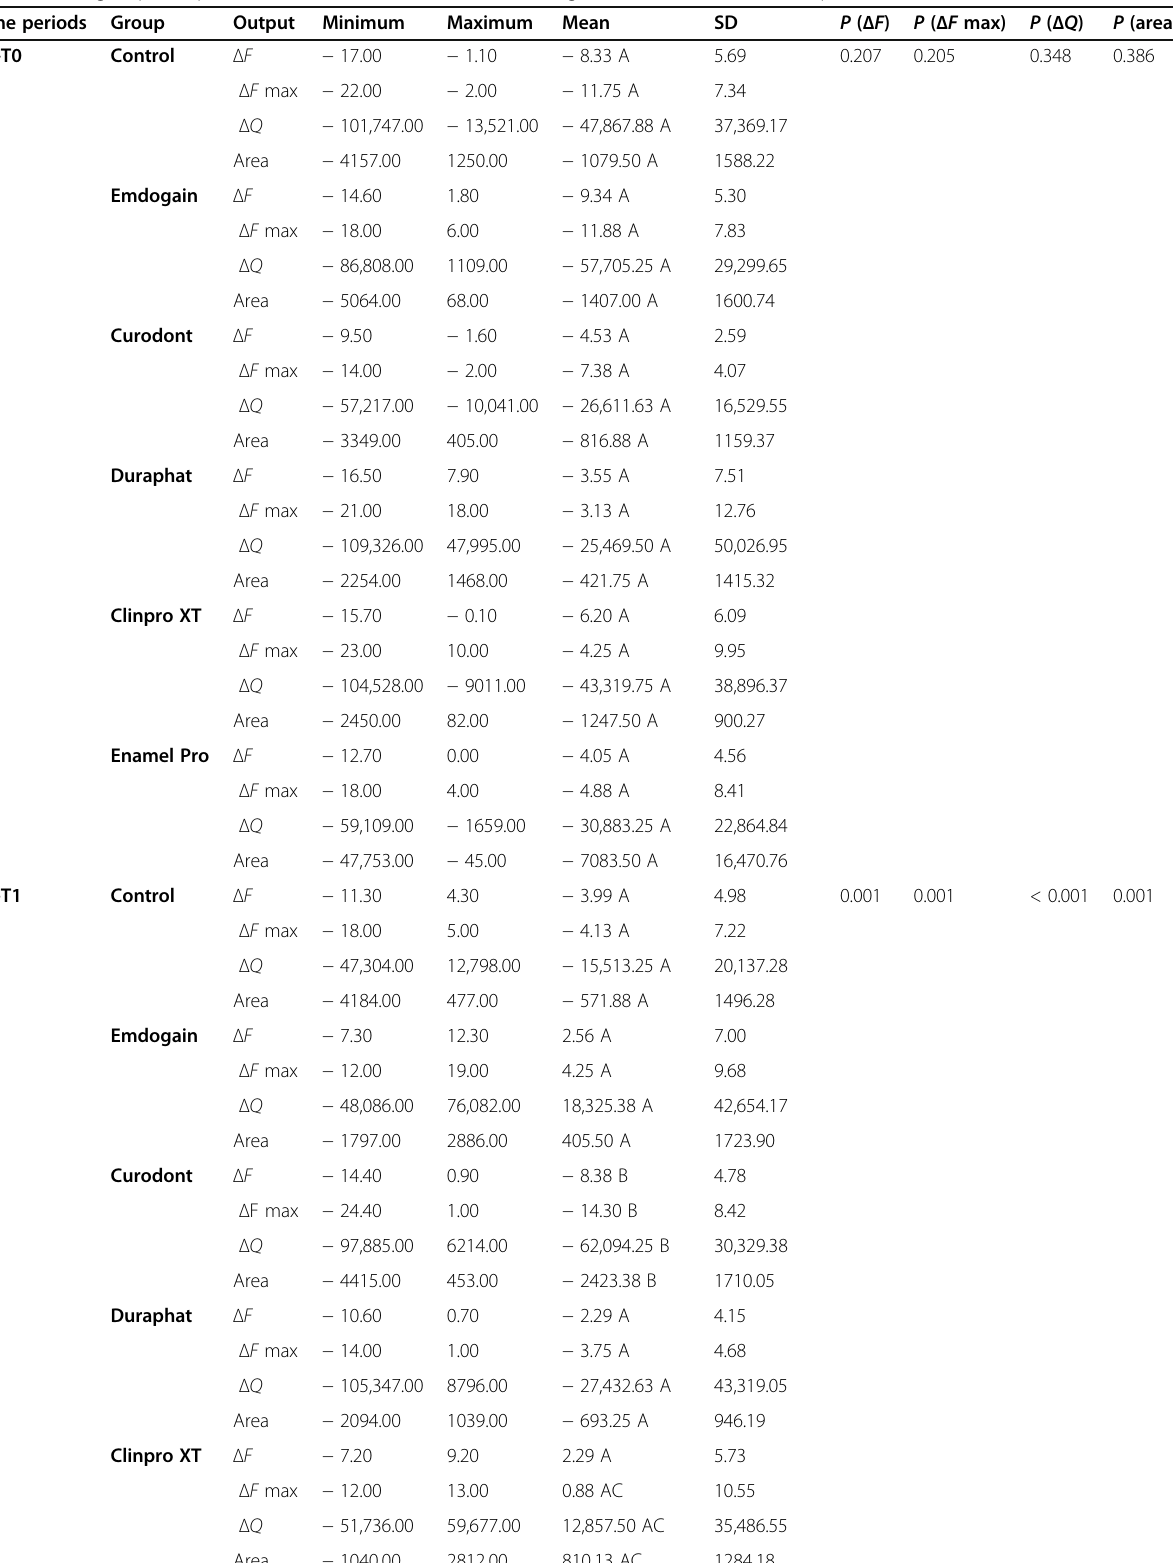
Table 3 Intergroup comparisons of the QLF measurements ’ changes between different time points Time periods